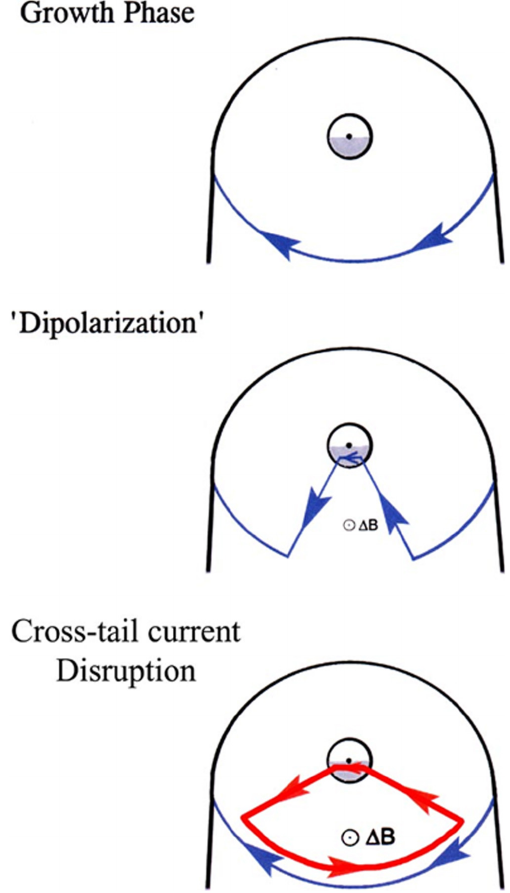
Fig. 15a. Schematic representation of changes of the cross-tail cur- rent. The top one shows the cross-tail current. The middle one suggests the diversion of the cross-tail current (so-called “current wedge”). The bottom one, same as the azimuthal current in Fig. 10, suggests the reduction of the cross-tail current caused by the return current of the westward